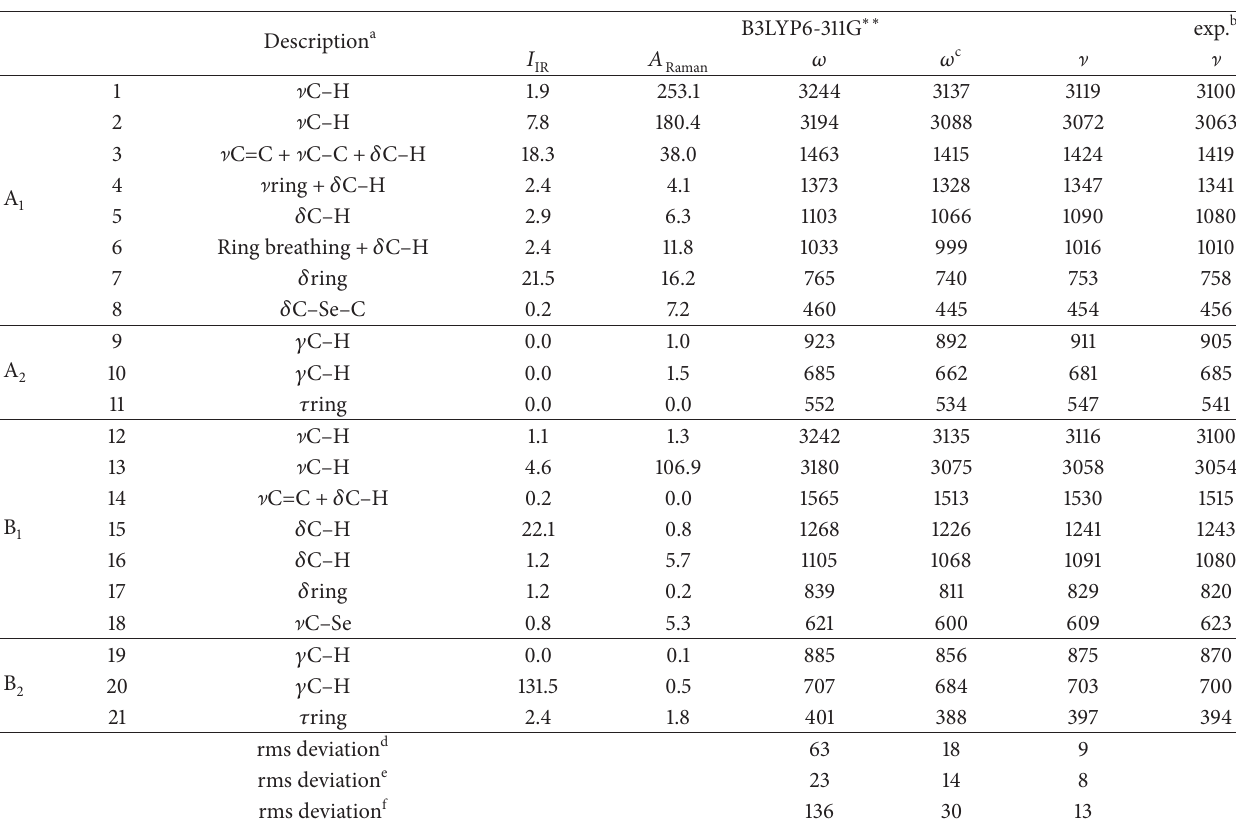
Table 2: Vibrational harmonic, 𝜔 , and anharmonic, ] , wavenumbers (cm − 1 ), infrared intensities, 𝐼 (˚A 4 /amu) of C H 4 4